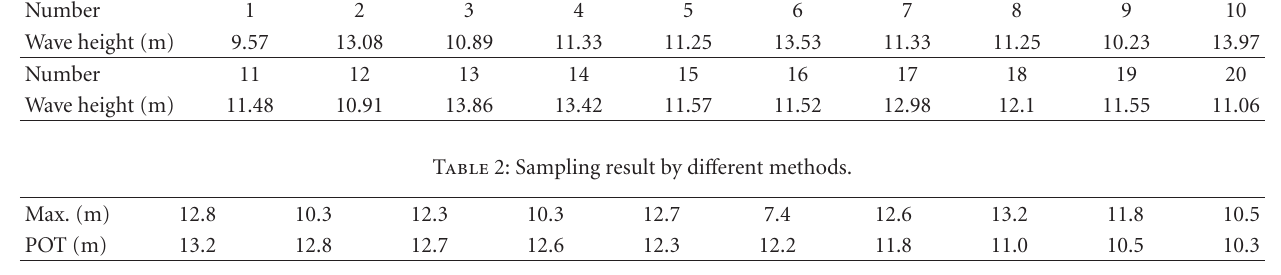
Table 4: Statistical data of storm surge in the South China